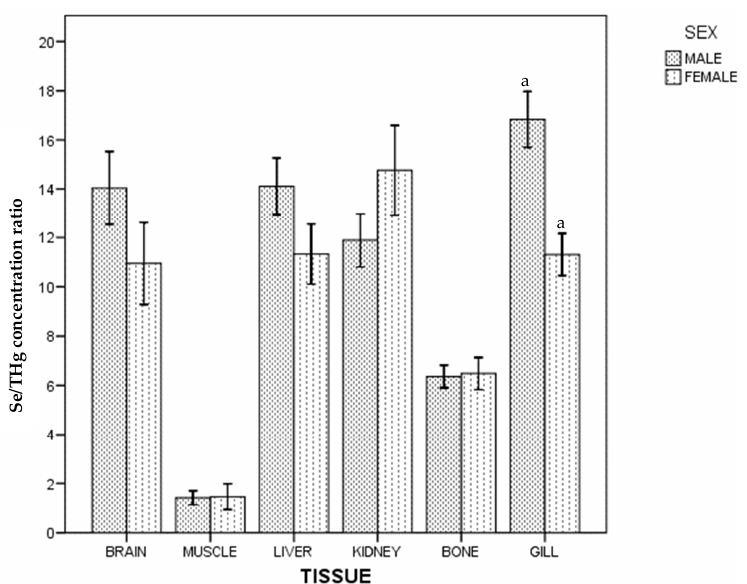
Figure 2. Se/THg concentration ratio of ABFT by tissue and sex. For each tissue, the same lowercase letter shows statistical differences between males and females. Bars show standard error. For each tissue, "the same lowercase letter (a in Figure 2) shows statistical differences between males and females”. For gill, “a” is the same lowercase in male and female, so there is statistical differences between them For HBV Se , in whole population and by sex, there were statistical differences between tissues: kidney > (liver~gill) > (brain~bone) > muscle. Figure 3 shows differences between females and males: females had a higher HBV Se than males in liver, but lower in gill ( p < 0.05).